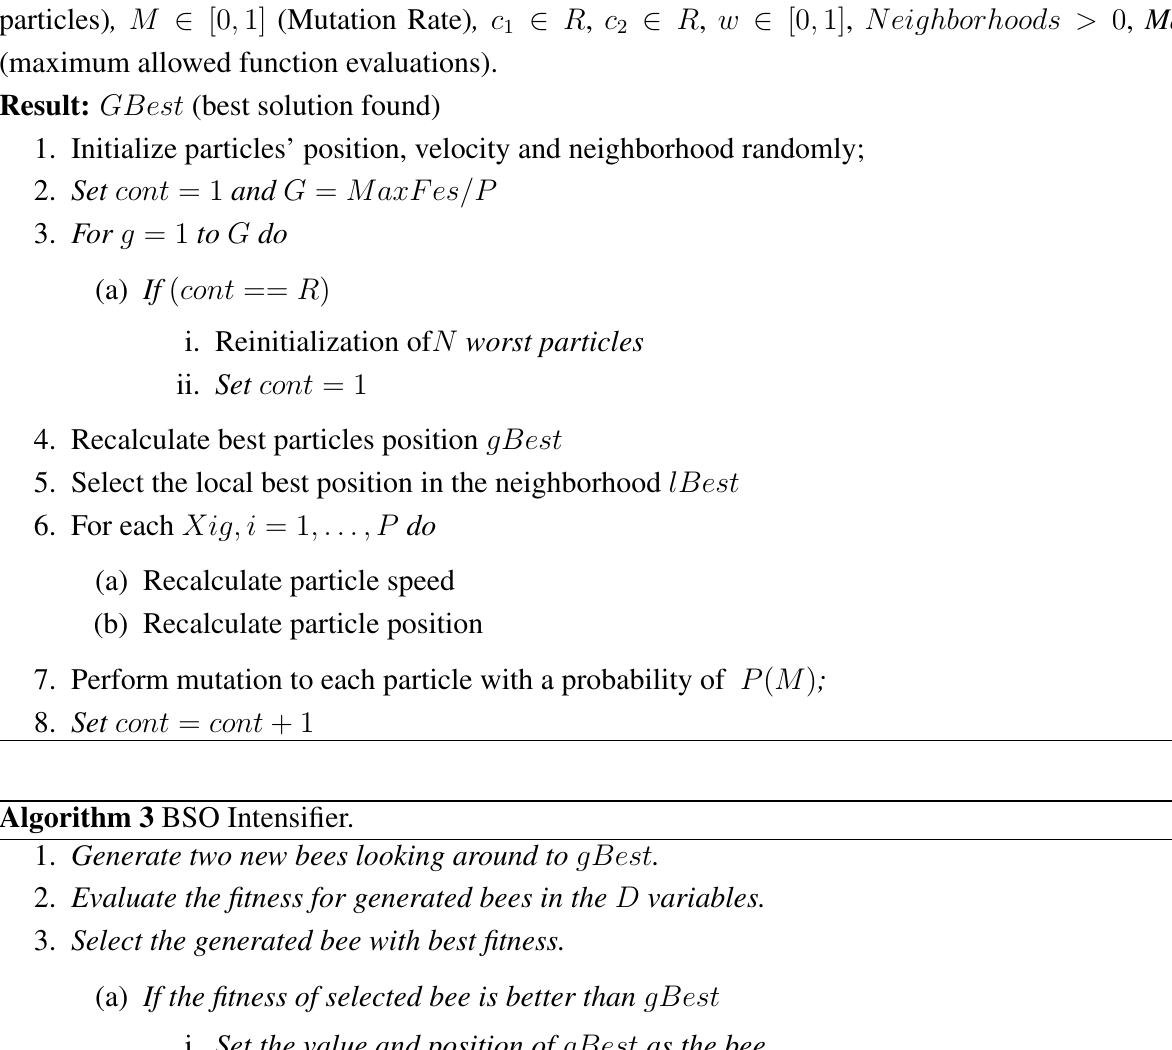
Algorithm 2 µ -PSO